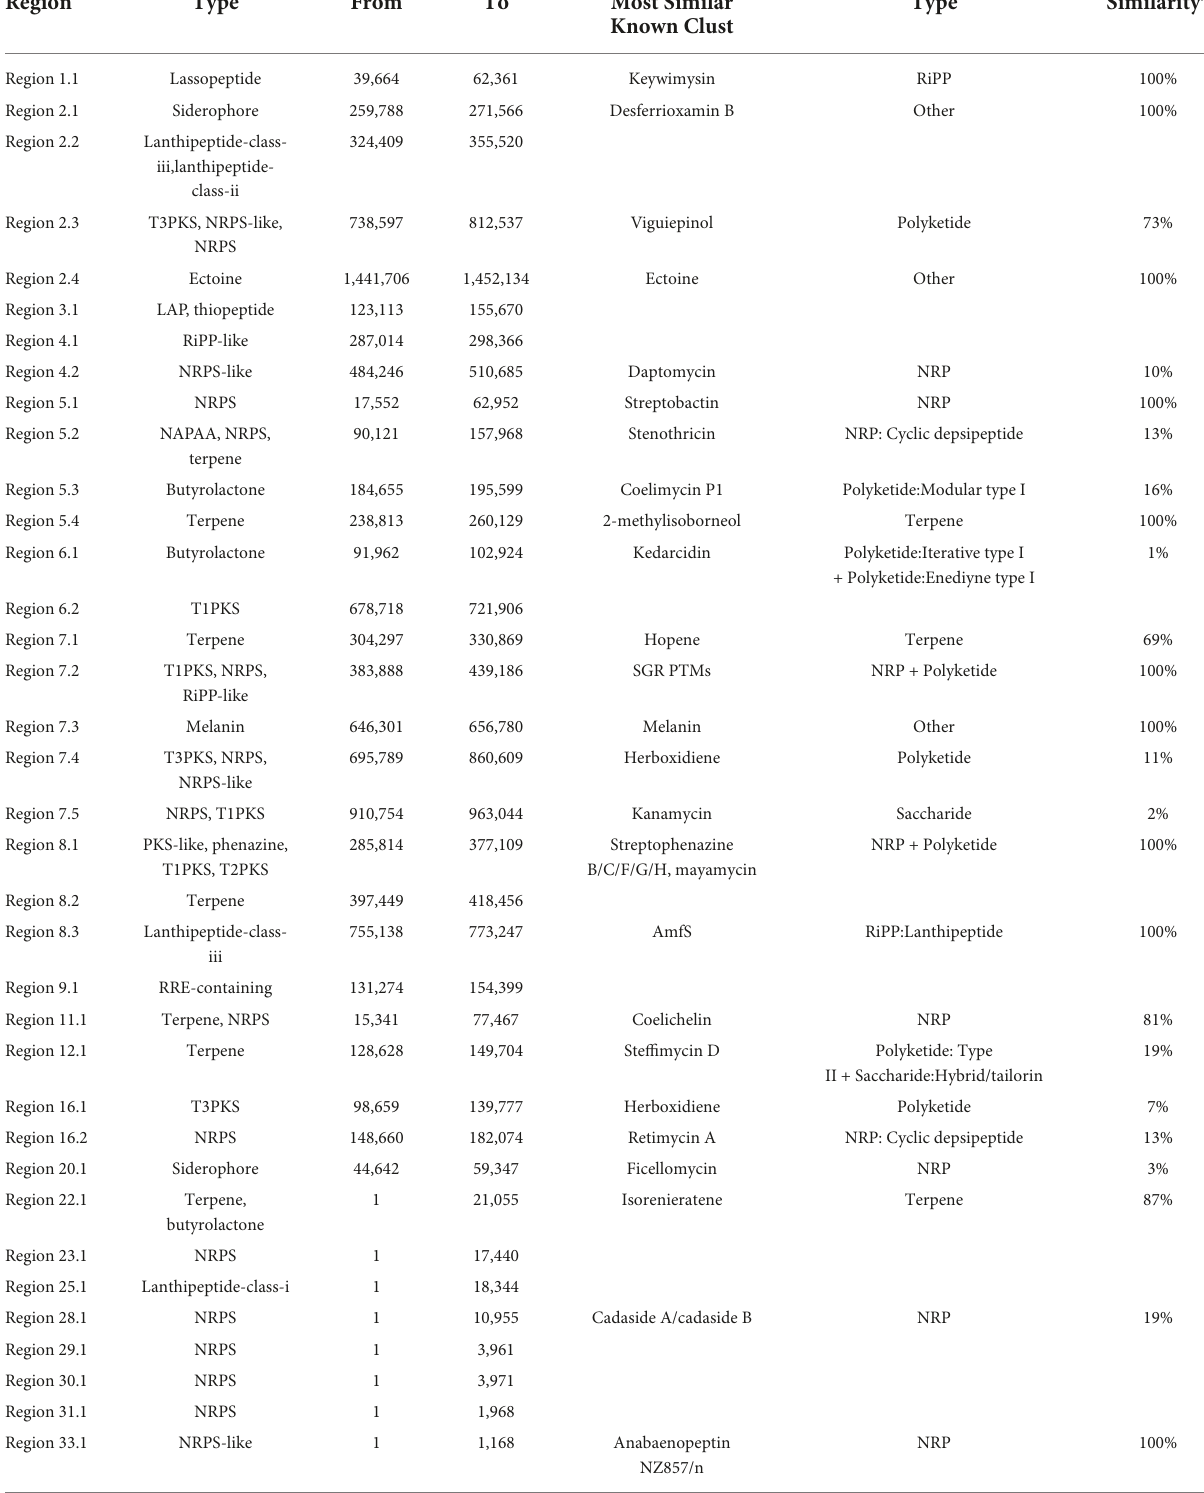
TABLE 5 Putative gene clusters coding for secondary metabolites in CS-7.